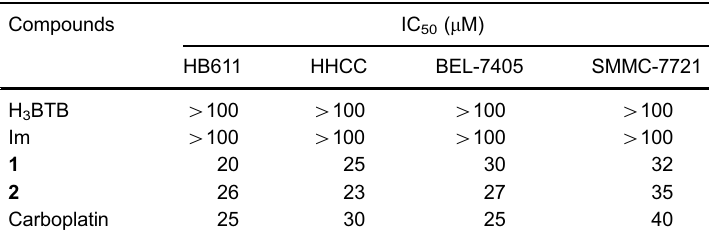
Table 2. Growth inhibitory effects of 1 , 2 , carboplatin, H 3 BTB and Im on HB611, HHCC, BEL-7405 and SMMC-7721 cancer cells.